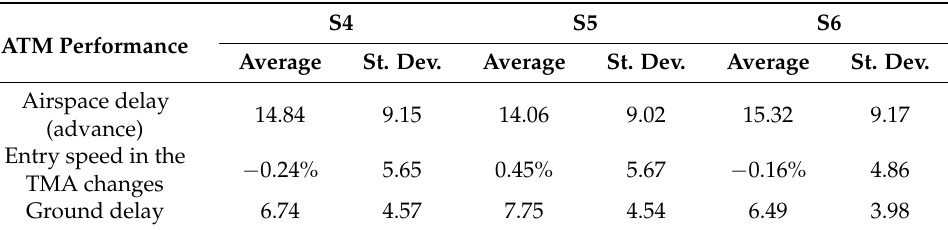
Table 10. ATM performance for scenarios S4, S5 and